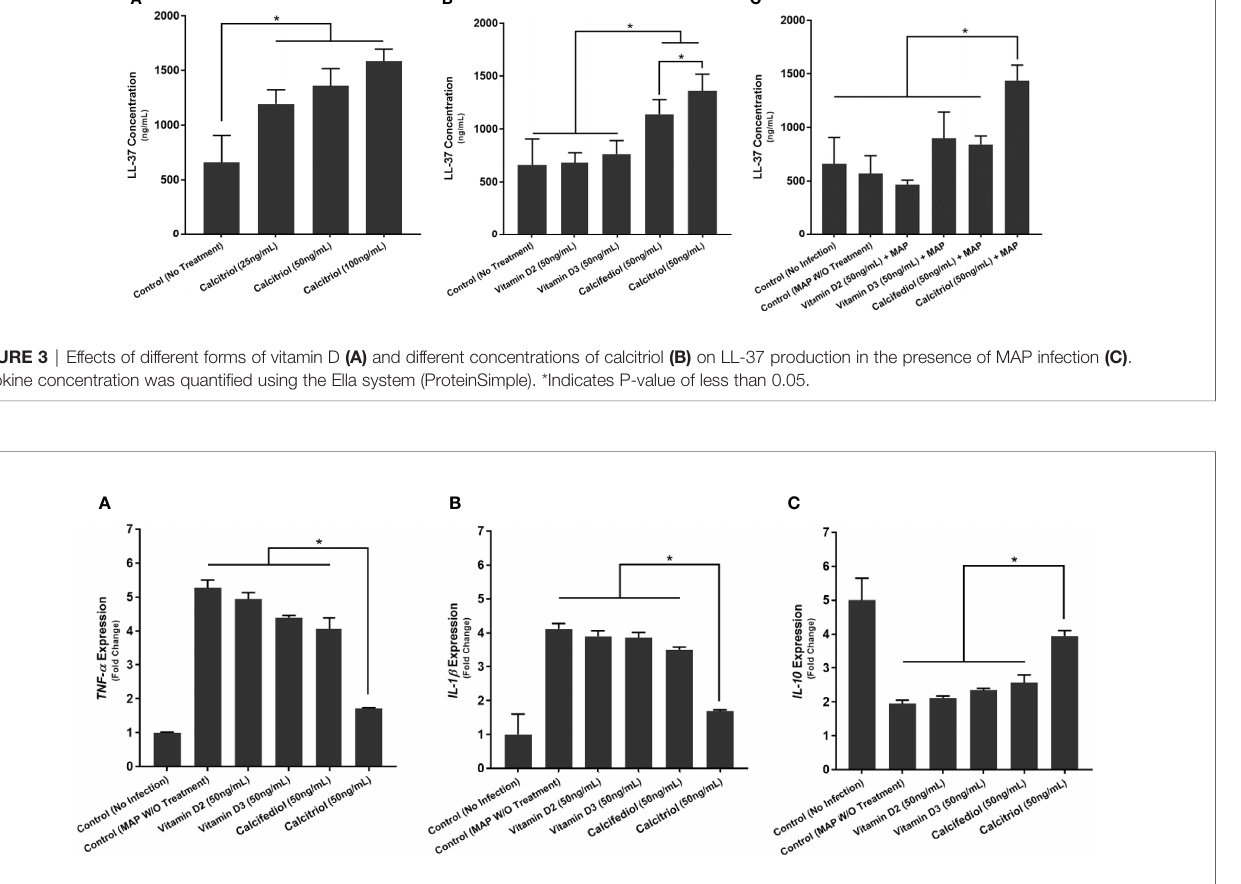
FIGURE 4 | Effects of Vitamin D Treatment on the expression of TNF- a (A) , IL-1 b (B) , and IL-10 (C) in MAP-infected macrophages. Relative expression was quanti fi ed using RT-qPCR. *Indicates P-value of less than 0.05.